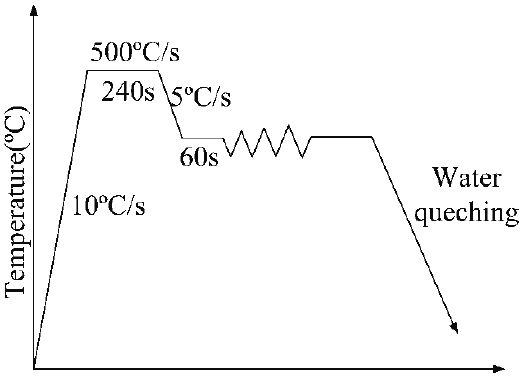
Figure 2. The flowsheet of hot compression tests.